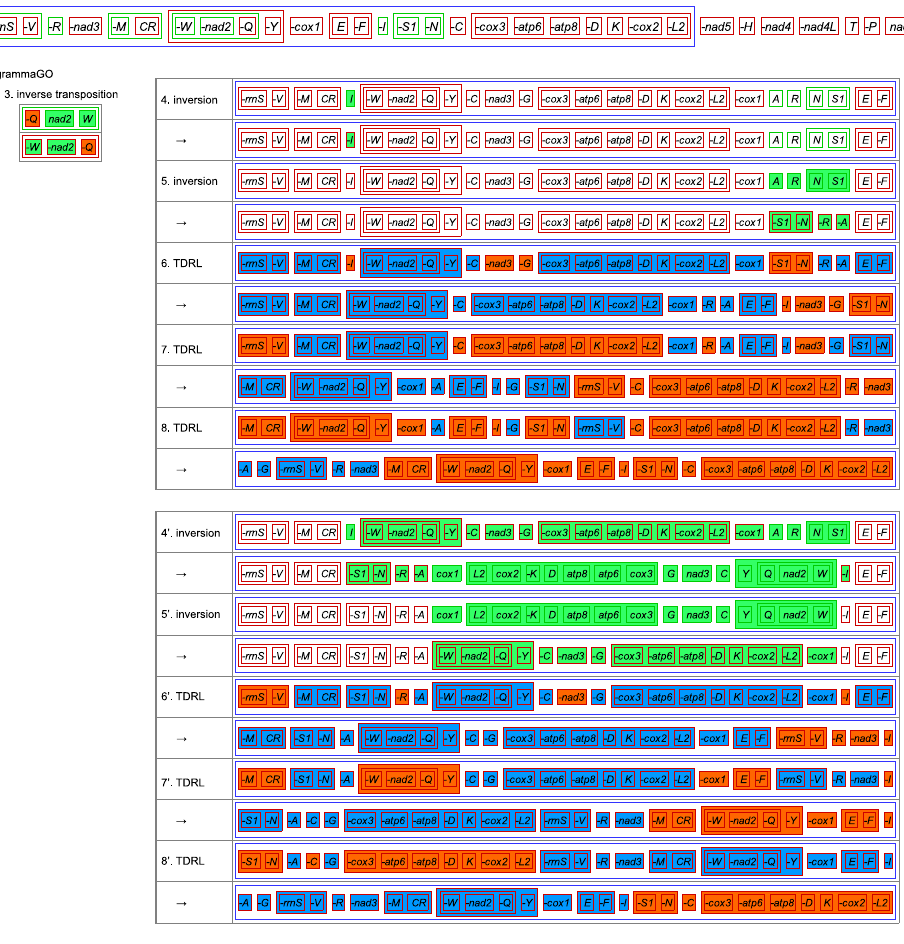
Figure 4. Evolution of gene order in mitochondrial genomes Trichogramma explained by software CREx. In total eight rearrangement operations occurred from presumed ancestral gene order of Chalcidoidea (ChalcidoidGO) to form the derived gene order of Trichogramma (TrichogrammaGO). Two alternative sets of scenarios were found, i.e. operations 4–8 and operations 4 ′ –8 ′